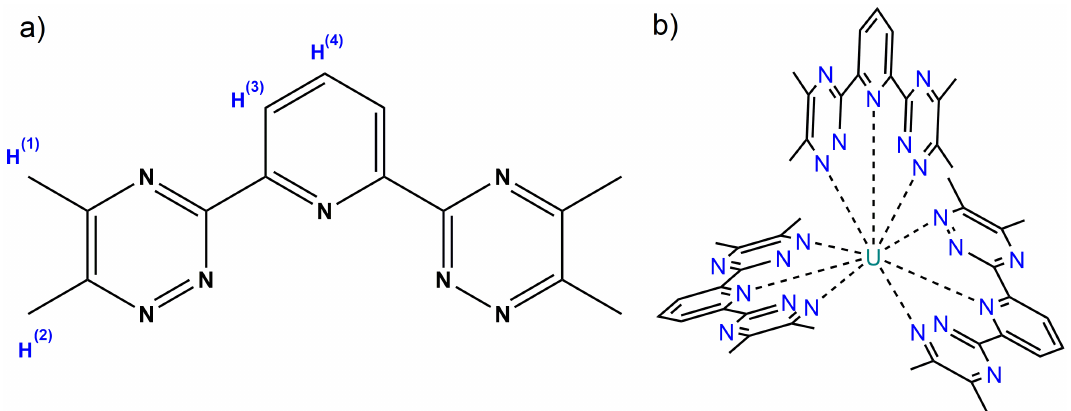
Figure 3. ( a ) The MeBTP ligand, labels identify the four types of chemically equivalent 1 H, ( b ) The full